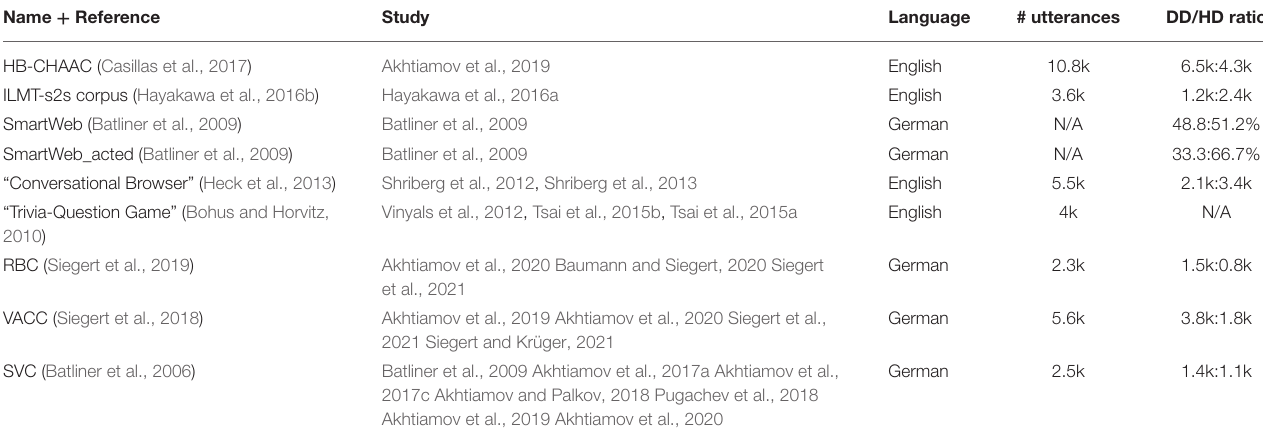
TABLE 3 | Overview of utilized existing